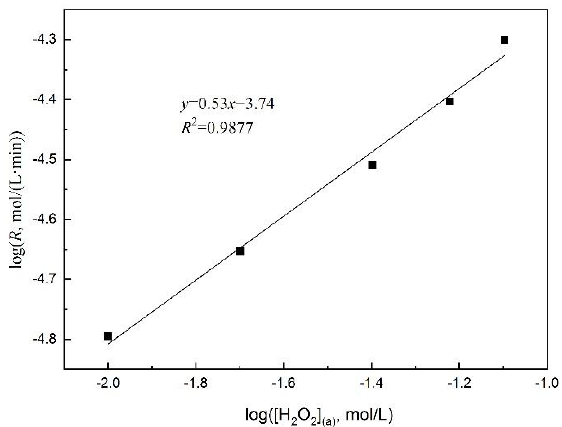
Figure 8. Effect of H 2 O 2 concentration in stripping agent on the stripping rate (experimental conditions: HEH/EHP concentration 0.2 mol/L, Ce 4+ concentration in organic phase 0.02 mol/L, HCl concentration 6 mol/L, temperature 25 °C and stirring speed 300 r/min).